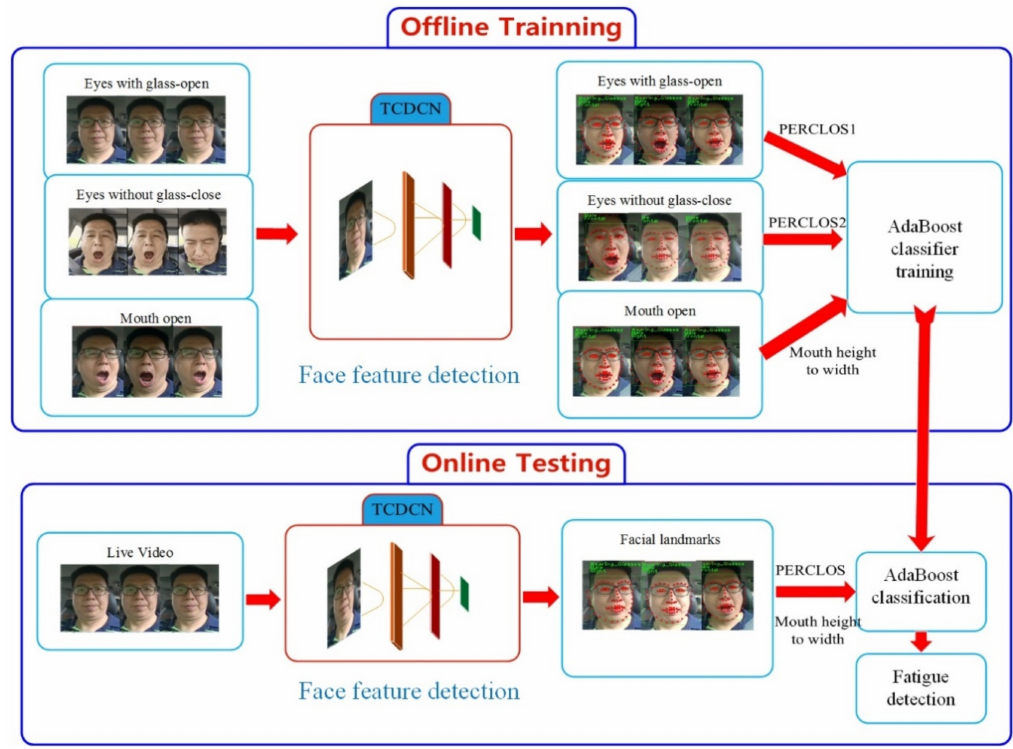
Figure 1. Schematic diagram of our